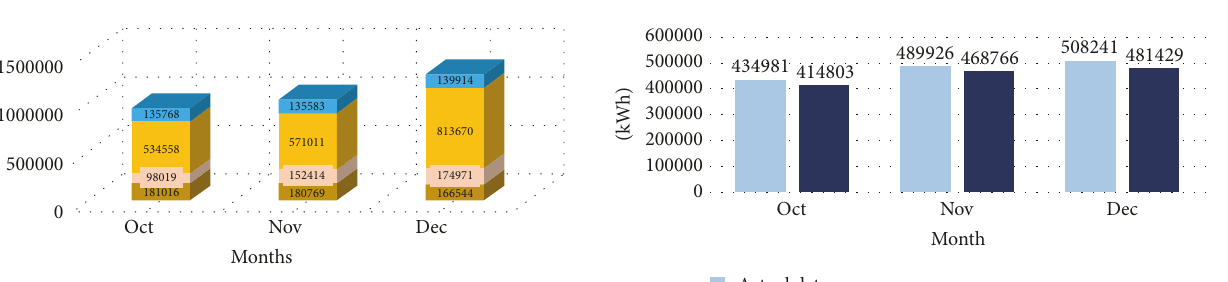
Figure 4: IDA ICE data for three months (October to December 2016).